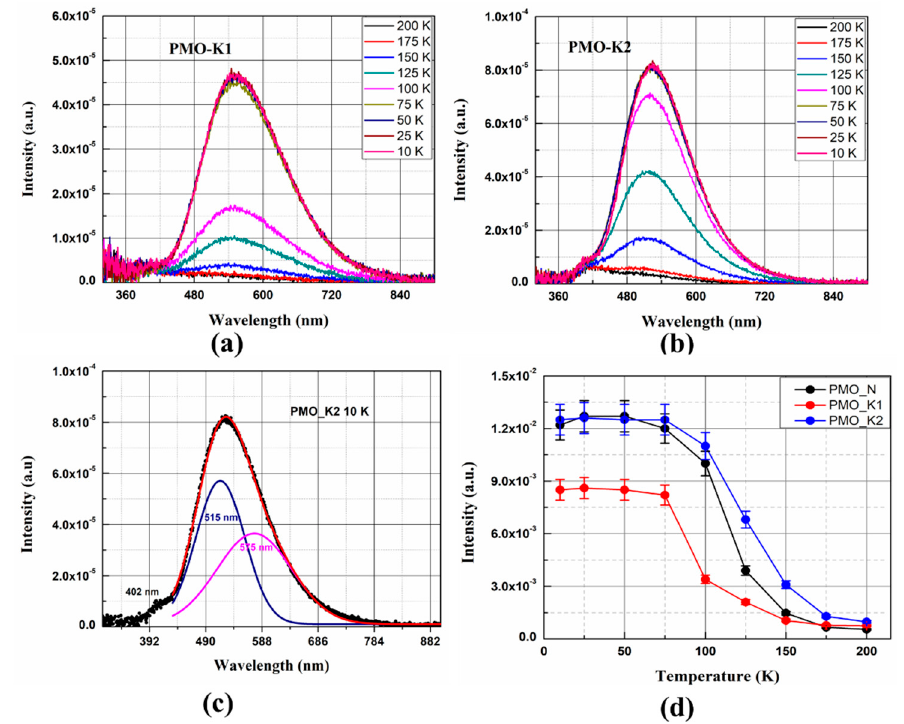
Figure 5. ( a , b ) Emission spectra of PMO-K1 and PMO-K2 at different temperatures, ( c ) emission spectrum of PMO-K2 at 10 K deconvoluted by two Gaussian distribution functions, and ( d ) temperature dependences of integrated luminescence intensities of PMO-K1 (red circles), PMO-K2 (blue circles) and PMO-N (black circles). All the measurements were performed under 4.42 eV excitation from an LED source.